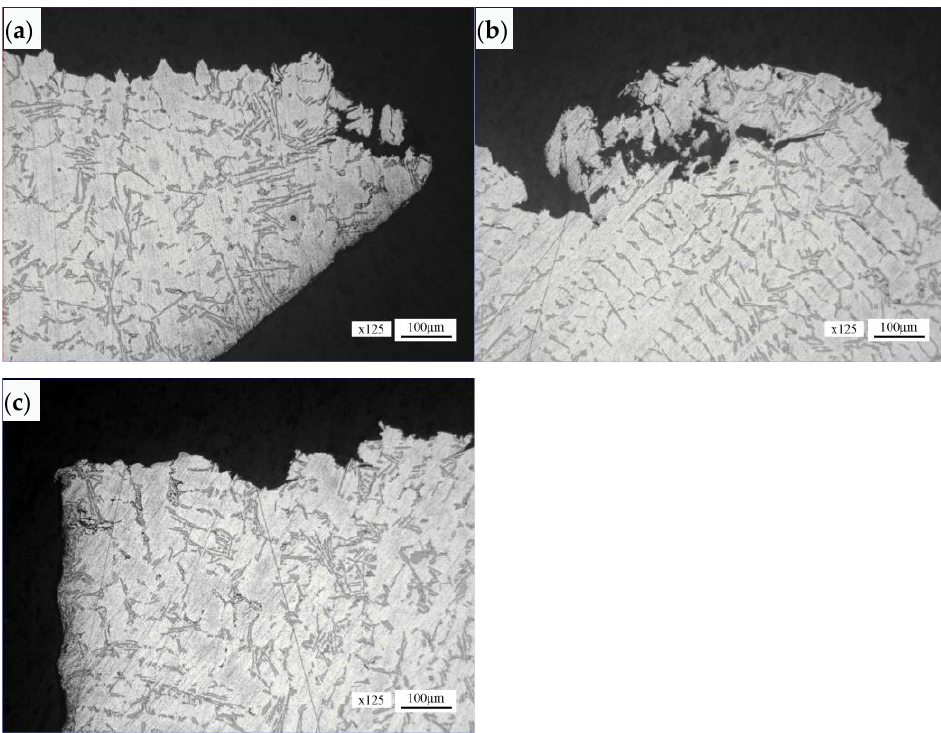
Figure 13. Microstructure morphology of the normal section of the safety buckle fracture section: ( a ) fracture initiation region, ( b ) fracture propagation region, ( c ) final fracture region.